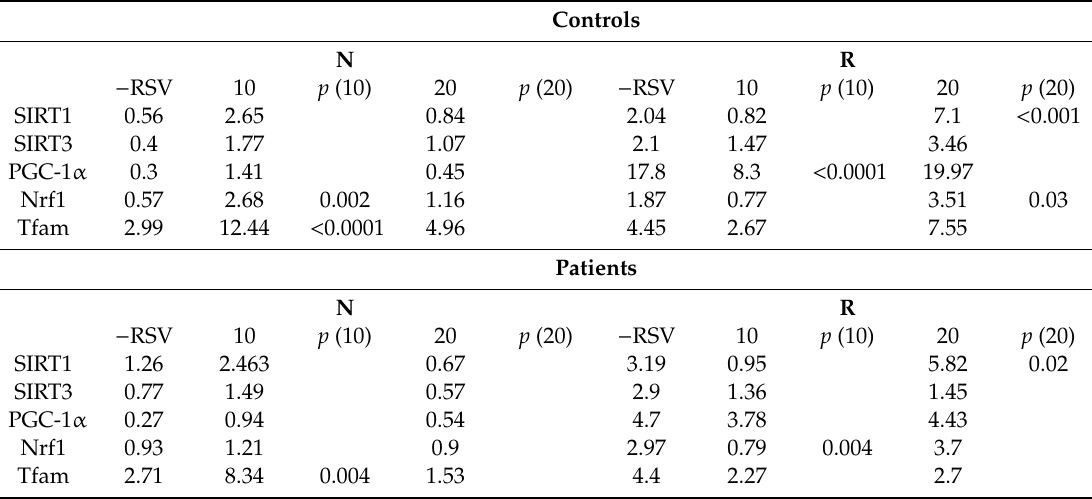
Table 6. The e ff ect of 10 or 20 µ M RSV on the relative expression rate of the genes SIRT1 , SIRT3 , PGC-1 α , Nrf1 , and Tfam measured under normal (N) or restricted (R) conditions in patients (n = 5) and controls (n = 5). p values are only shown in the case of significant di ff erences between the two